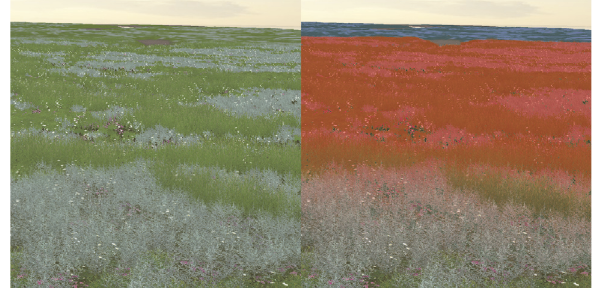
Figure 17: Transition of the various LODs in the virtual Pauli- napolder. Green is the regular plant models, red is the billboards, and blue is the terrain color map.